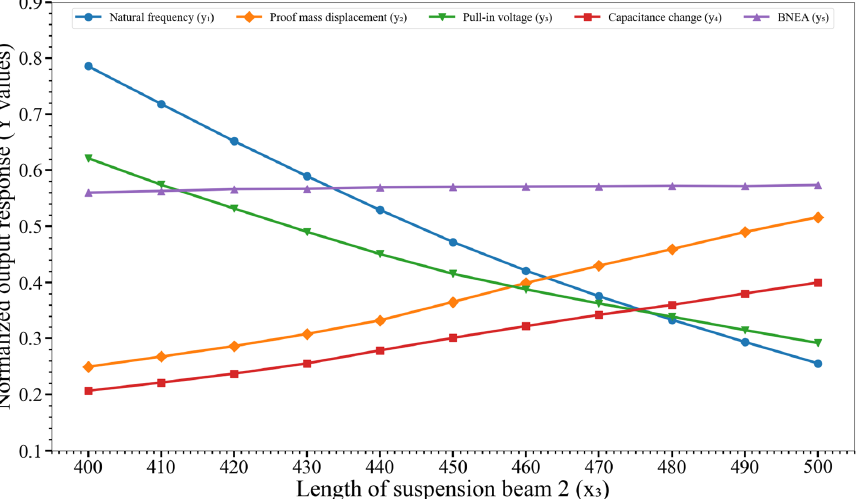
Figure 9. Effect of variation of the length of suspension beam 2 (x 3 ) on the output responses y 1 , y 2 , …, y 5 . Key. y 1 : natural frequency; y 2 : proof mass displacement; y 3 : pull-in voltage; y 4 : capacitance change; and y 5 : BNEA.